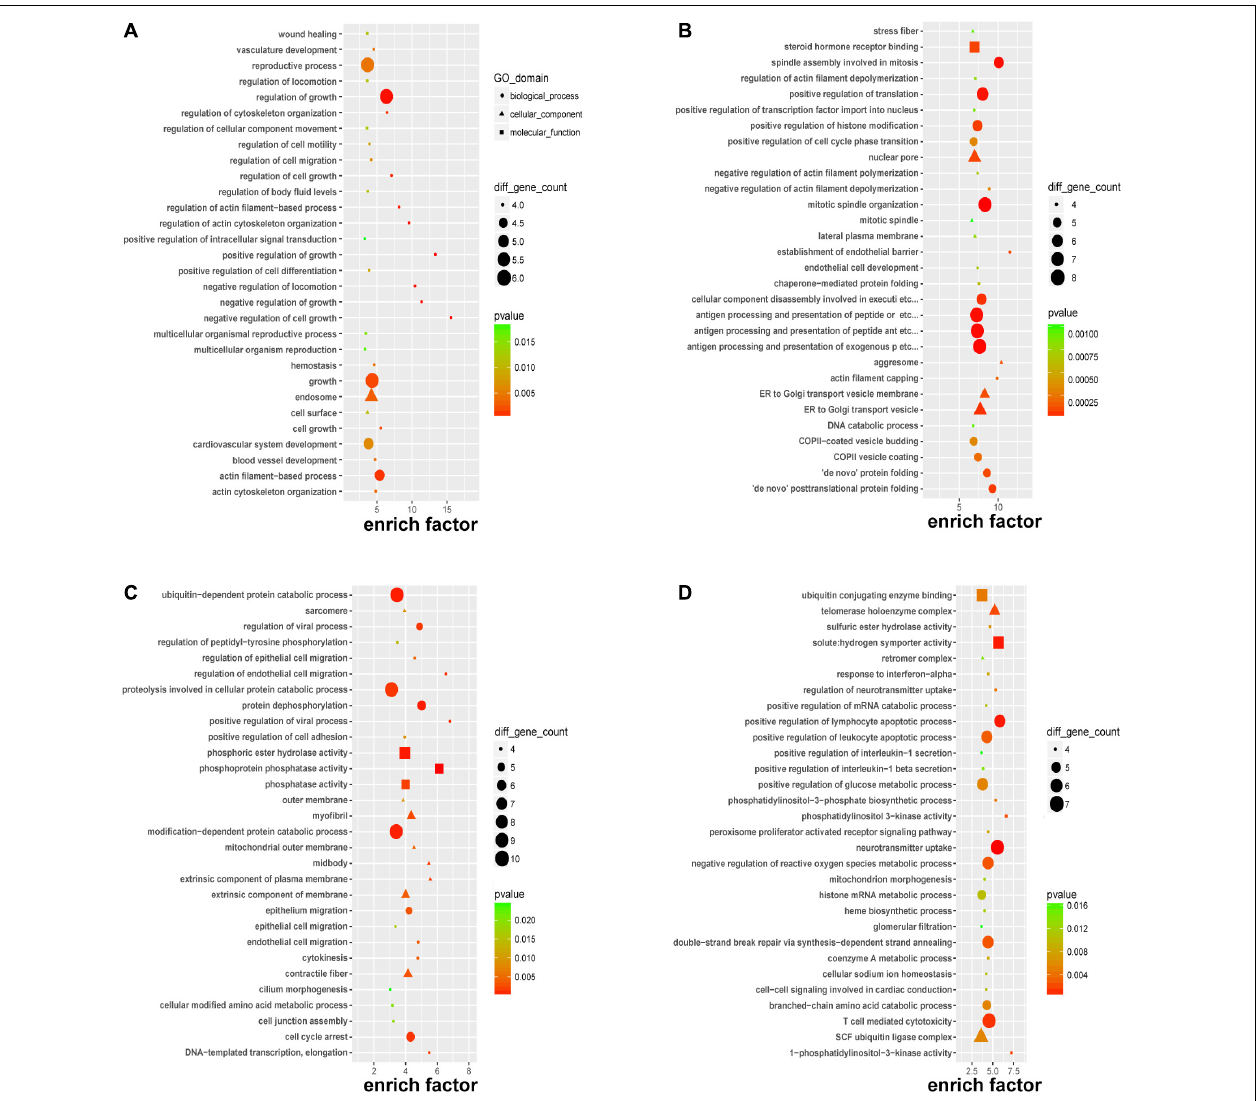
FIGURE 3 | Gene Ontology (GO) enrichment of DERNAs. GO enrichment of DEmRNAs (A) , host genes of DEcircRNAs (B) , cis- regulated genes of DElncRNAs (C) , and trans- regulated genes of DElncRNAs (D) .